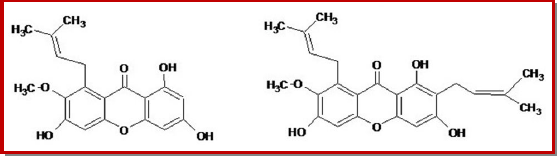
Figure 1: Chemical structure of dulxanthone (left) and alpha- mangostin